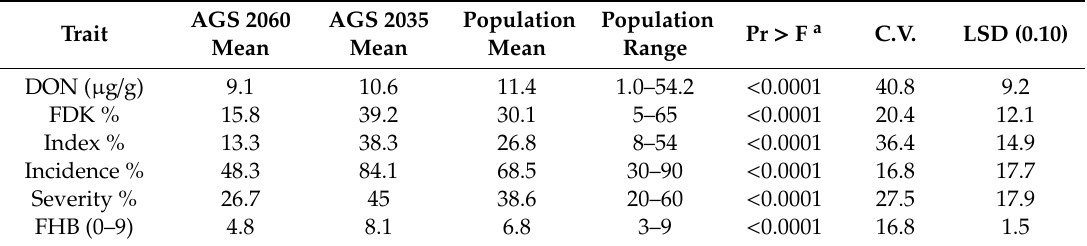
Table 3. Descriptive statistics for FHB resistance ratings of AGS 2060 x AGS 2035 DH population at Winnsboro 2018.